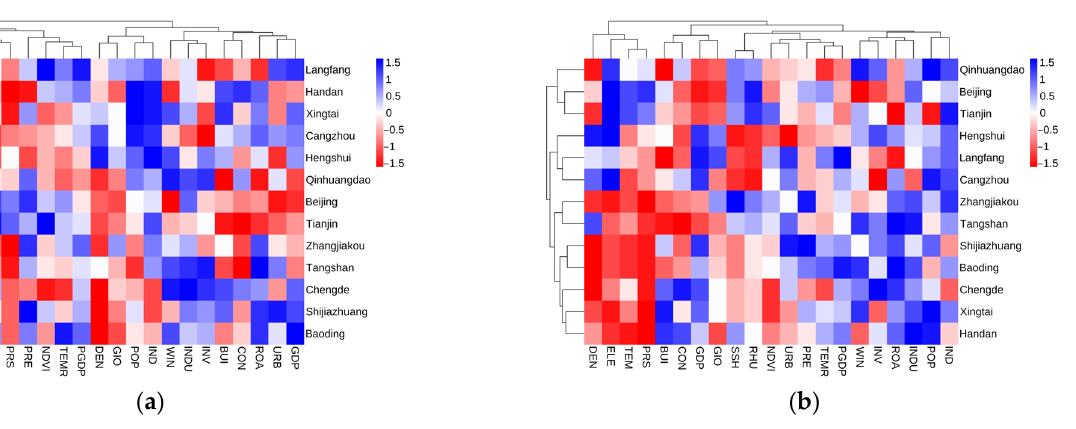
11 of 18 Table 3. Performance evaluation of random forest regression models from 2000 to 2016. Year